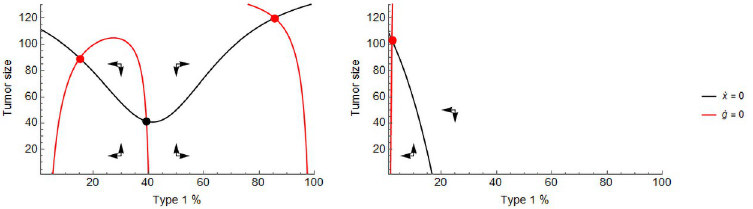
Fig 3. Zero-isoclines with and without therapy. The zero-isoclines of the system defined by (3) and (4) with therapy off (left) and on (right). If therapy is off, there are two stable equilibria (red dots) comprising mostly type 1 and mostly type 2 cells, respectively, and a mixed unstable equilibrium (black dot). With therapy on, the only stable equilibrium consists of mostly type 2 cells. Parameters: r 1 = 0.4, r 2 = 0.2, d 1 = d 2 = 0, K = 150, α = 2, c 1 = c 2 = 0.05, m 1 = m 2 = 0.01, γ 1 = 0.4, γ 2 =